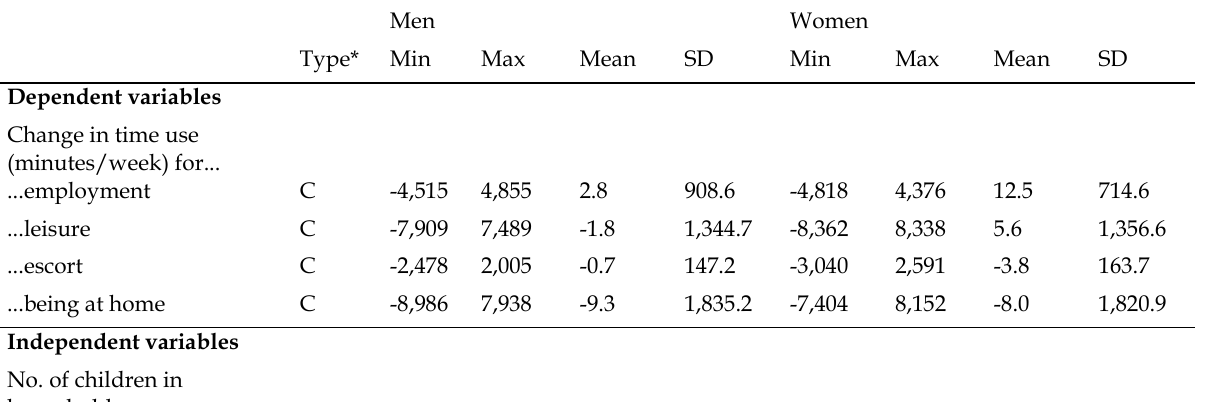
Table 1. Continuous variables used in regression: descriptive statistics Men